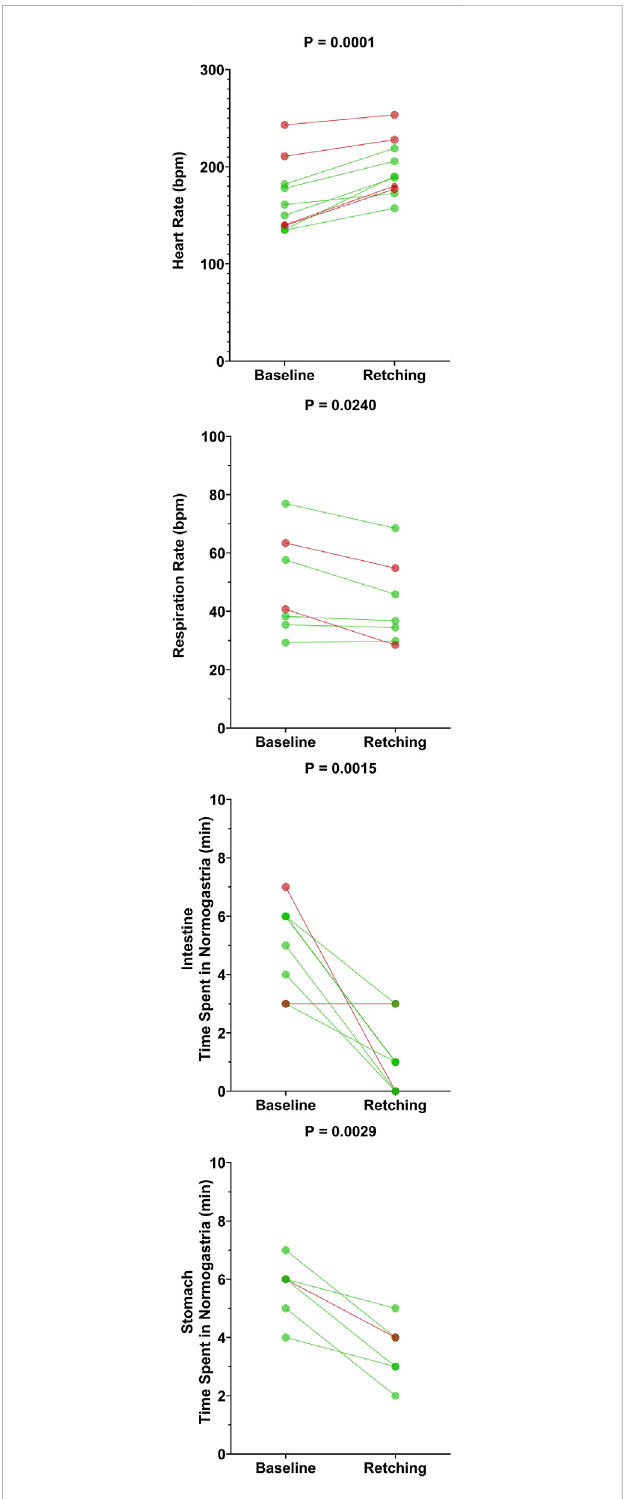
FIGURE 6 Effects of CuSO 4 administration on physiologic parameters associated with the fi rst retching episode. Each data point represents an average of data over 10 min during the baseline (prior to CuSO 4 administration) or retching periods. For the six animals that retched within 10 min of providing CuSO 4 (data indicated by green lines and symbols), the retching period was de fi ned as the 10 min following CuSO 4 administration. For the four animals where retching occurred at longer latency (data indicated by red lines and symbols), the retching period was de fi ned as the 10 min prior to the fi nal retch of the initial